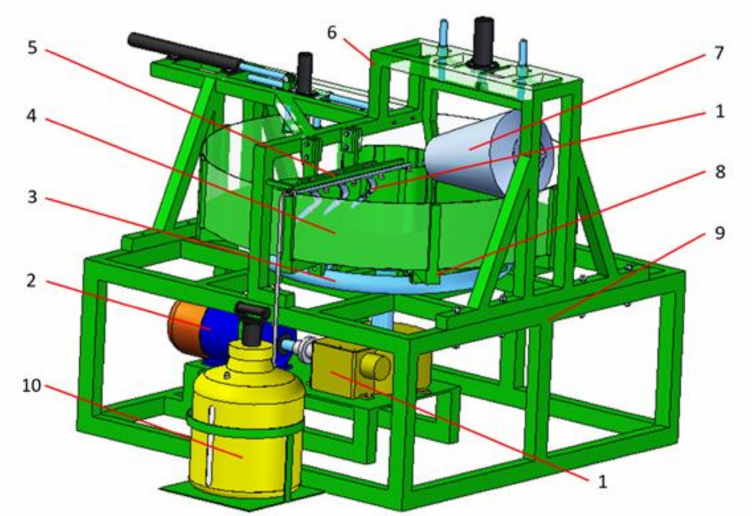
Figure 1. Test stand: 1—transmission, 2—motor, 3—running rail, 4—bowl, 5—sample holder, 6—supporting frame, 7—compacting roller, 8—bowl frame, 9—main frame, 10—wetting system